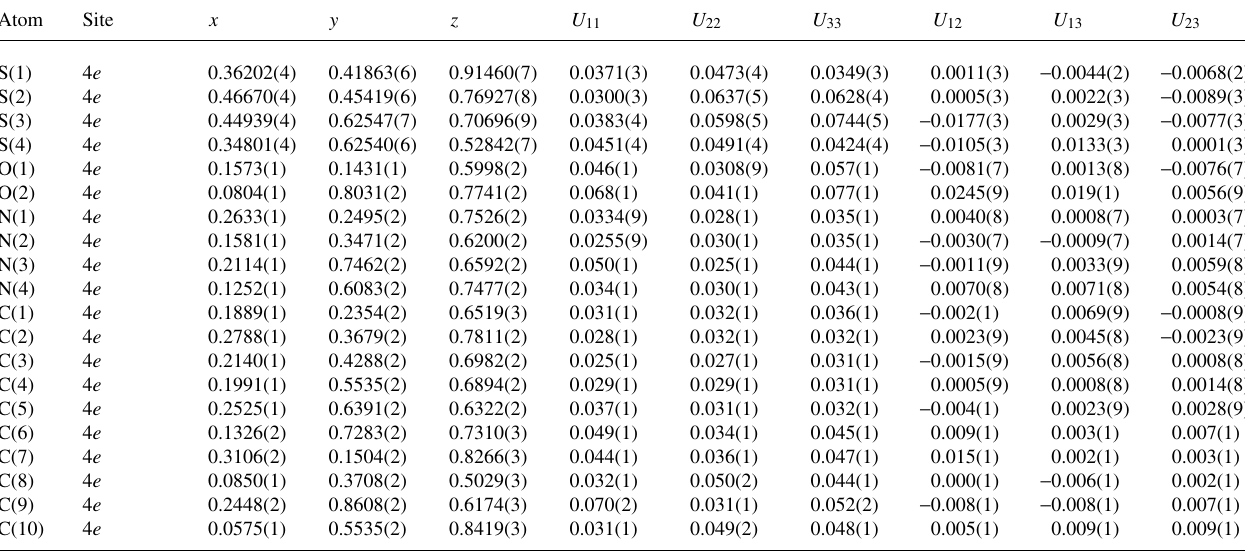
Table 3. Atomic coordinates and displacement parameters (in Å 2 )